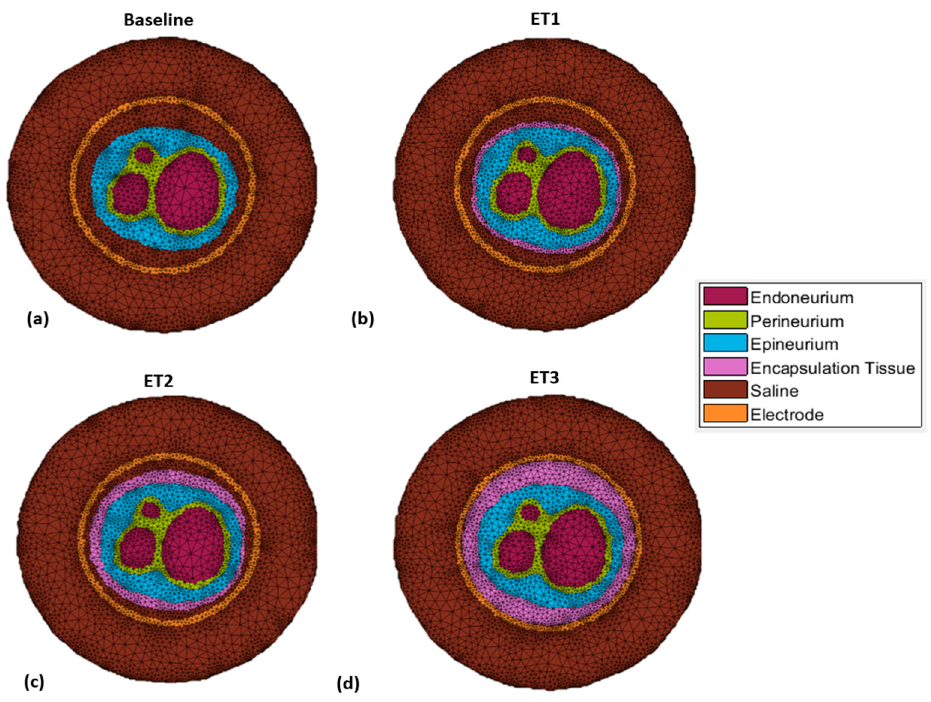
Figure 3. Top–down view of FE mesh models from: ( a ) no encapsulation tissue to ( d ) the full en- capsulation of the nerve.